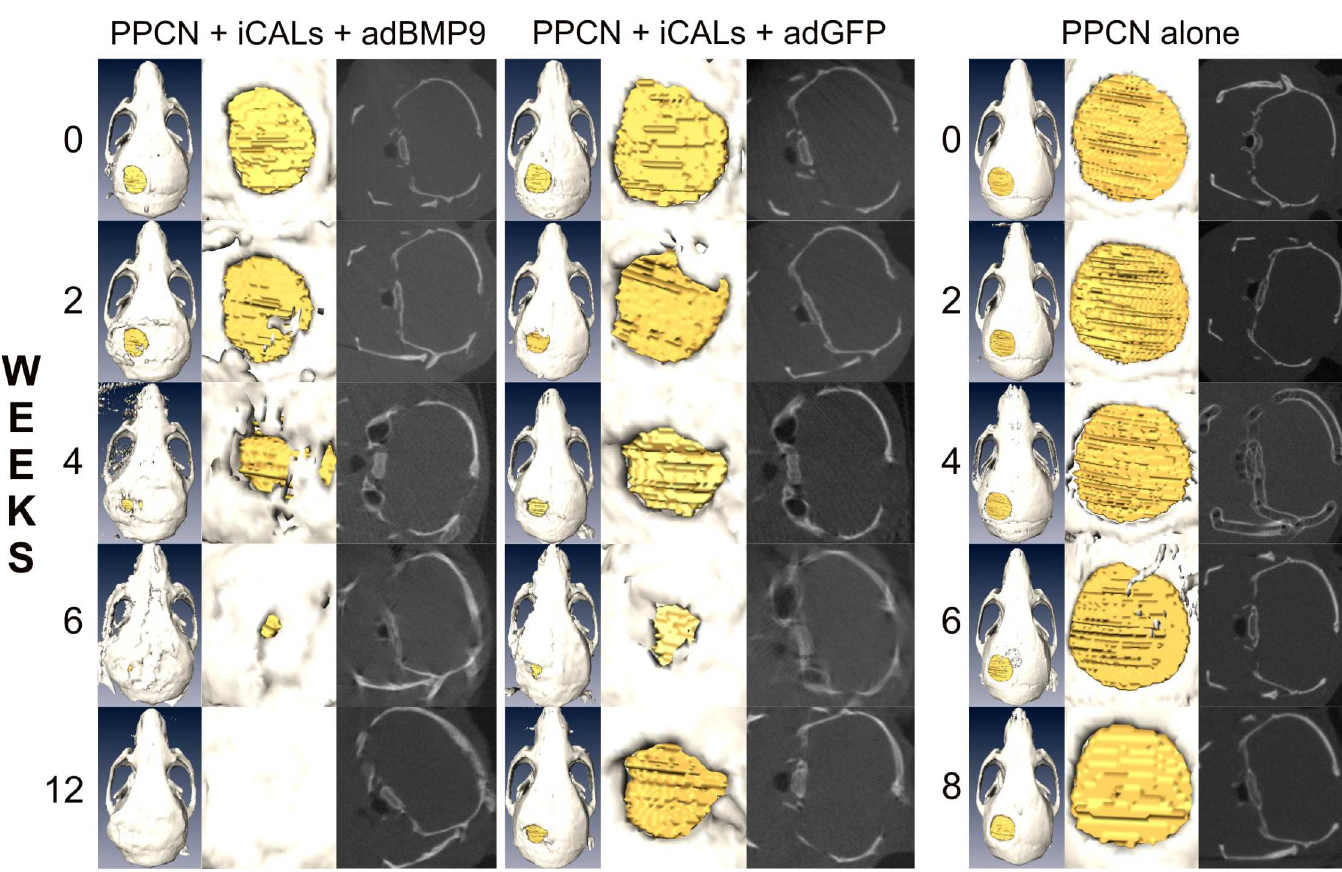
Fig 2. Time-course microCT imaging of the calvarial defects. At 24–48 hours postoperatively, baselinemicroCT imagingwas performed and analyzedto determinedefect volume. Follow-upimagingand analysiswas performed at 2, 4, 6, 8, and 12 weeks postoperatively to quantify residual defect volume and new bone ossification. Representative images are